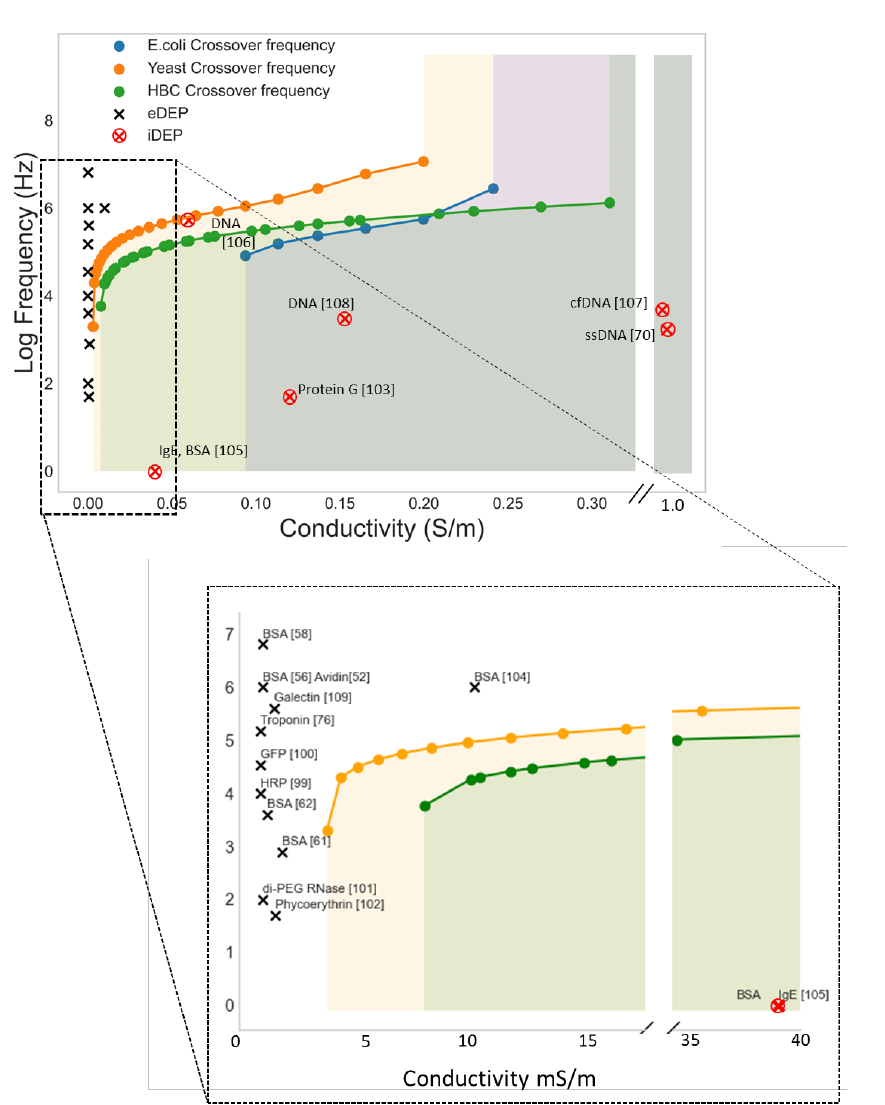
Figure 6. Simulated lower cross-over frequencies (nDEP to pDEP) for E.coli, Yeast cells (Saccharo- myces cerevisiae), and Human B cell (HBC) as a function of medium conductivity σ m . The cells’ crossover frequencies were calculated with the software MyDEP [98]. The black and red marks shows pDEP conditions reported in the literature for a variety of biomolecules [52,56,58,61,62,70,76,99–109]. The colored areas display conditions below the cross-over frequency (medium conductivity and frequencies) where the cells experience nDEP. Accordingly, pDEP of biomolecules in this area would enable an efficient separation.